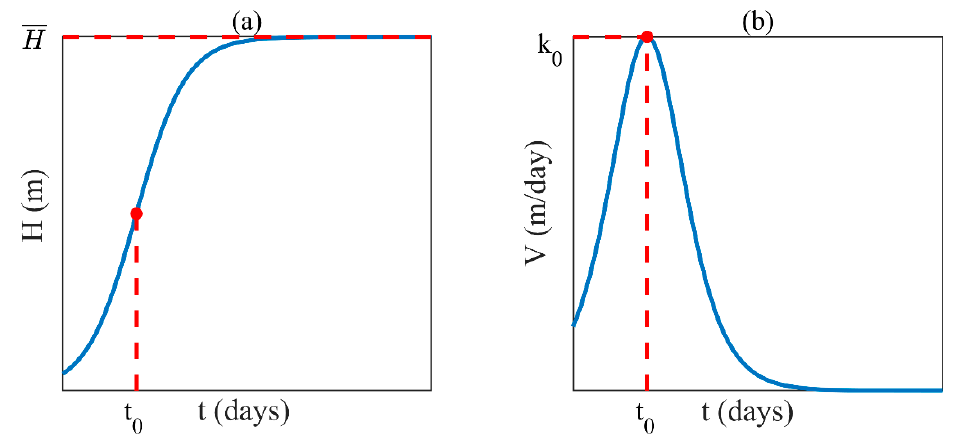
Figure 2. Flowchart of the height inversion implementation.